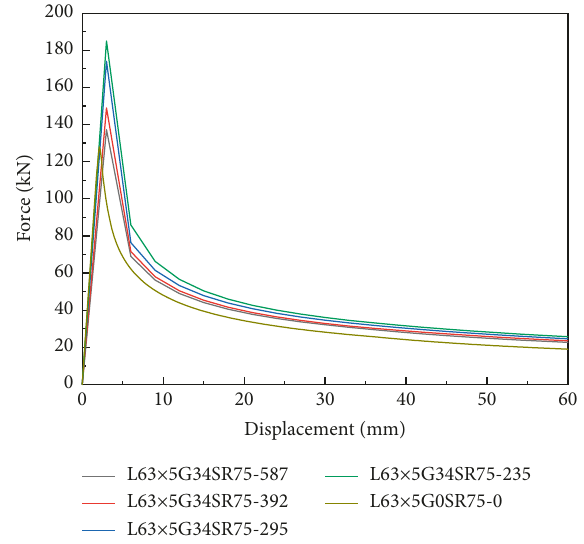
Figure 5: Force-displacement curve (L63 × 5